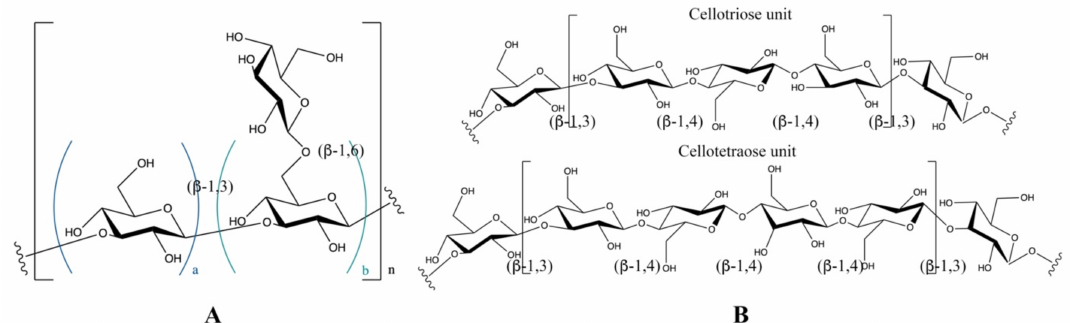
Figure 1. Chemical structures of β -glucans. The glucose monomers are shown following the symbol nomenclature for glycans. ( A ) The β -1,3-linked backbone of β -glucan with different branching degree of β -1,6-linked glucose. ( B ) The β -1,3-1,4-linked backbone of β -glucan, DP3: cellotriosyl, DP4: